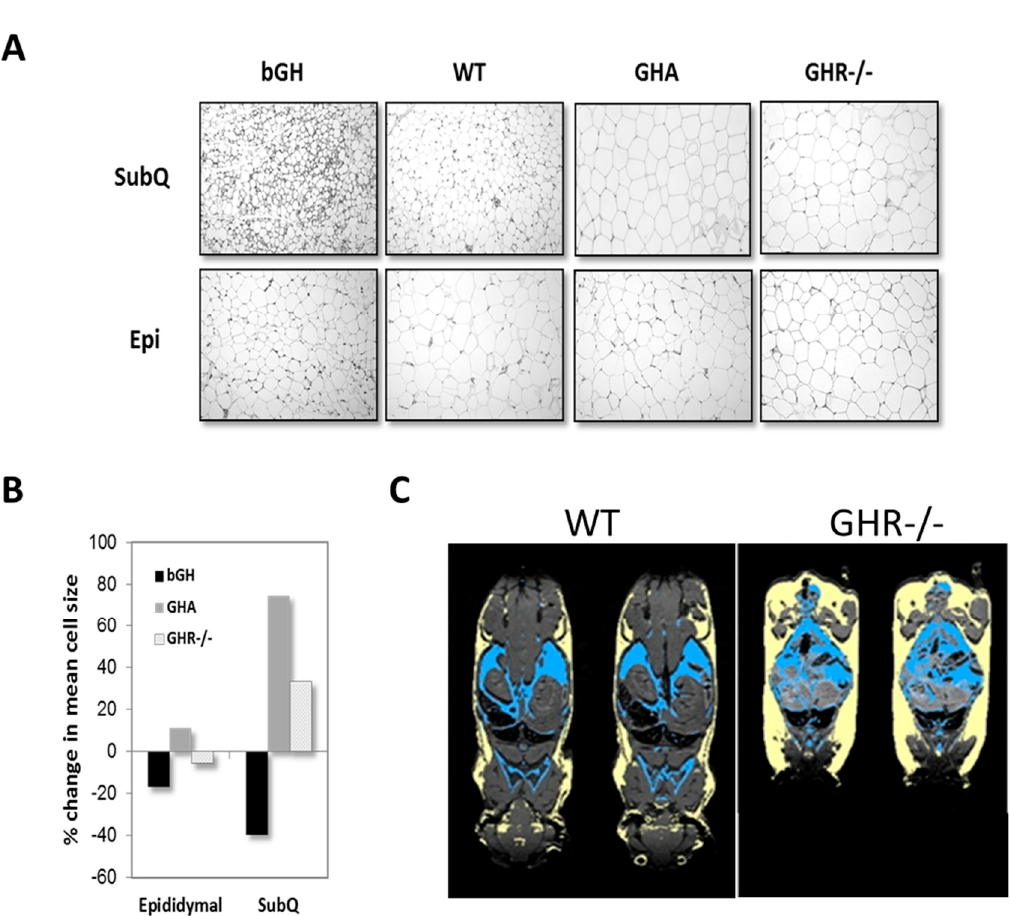
Figure 4. Depot-specific differences due to extremes in GH. ( A ) Hematoxylin and eosin staining of subcutaneous (SubQ) and epididymal (Epi) AT. Tissue samples were obtained from six-month-old GHR-/-, GHA, bGH and control mice. ( B ) Quantification of adipocyte size from these mice. ( C ) Adiposity in GHR-/- mice. Regional body fat distribution of male WT mice (left) and male GHR-/- mice (right) using magnetic resonance imaging (MRI). The mouse is positioned with the anterior part at the bottom of the image. Subcutaneous AT is highlighted yellow and intra-abdominal blue. Adapted with permission from [36,37]. Copyright 2011 Elsevier.